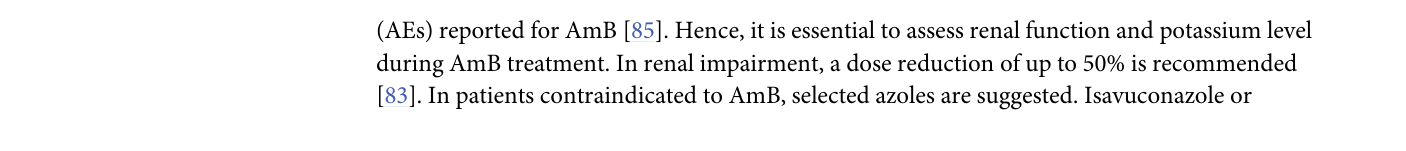
(AEs) reported for AmB [85]. Hence, it is essential to assess renal function and potassium level during AmB treatment. In renal impairment, a dose reduction of up to 50% is recommended [83]. In patients contraindicated to AmB, selected azoles are suggested. Isavuconazole or